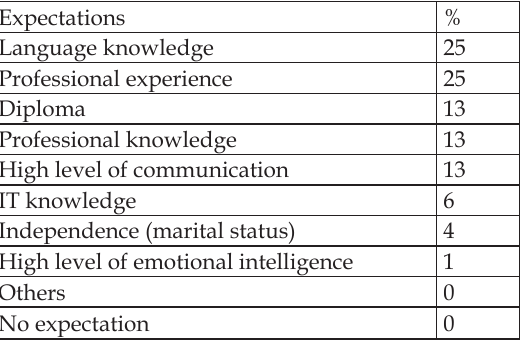
Table 2. Chart 2: Expectations of Employers.